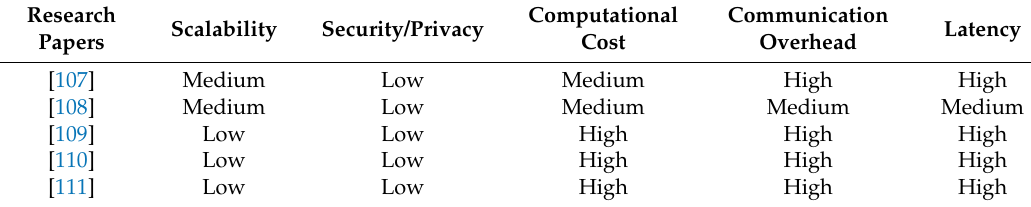
Table 10. Hybrid security and privacy schemes performance.